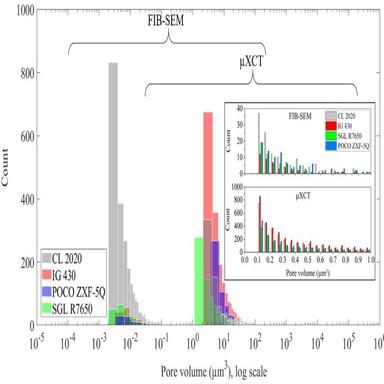
Multi-length scale porosity distribution of the four grades of graphite in terms of pore volume, horizontal brackets represent the predominant pore size ranges covered by FIB and μXCT; insert plot shows distributions within 0.1–1 μm3. (For interpretation of the references to colour in this figure legend, the reader is referred to the web version of this article.)